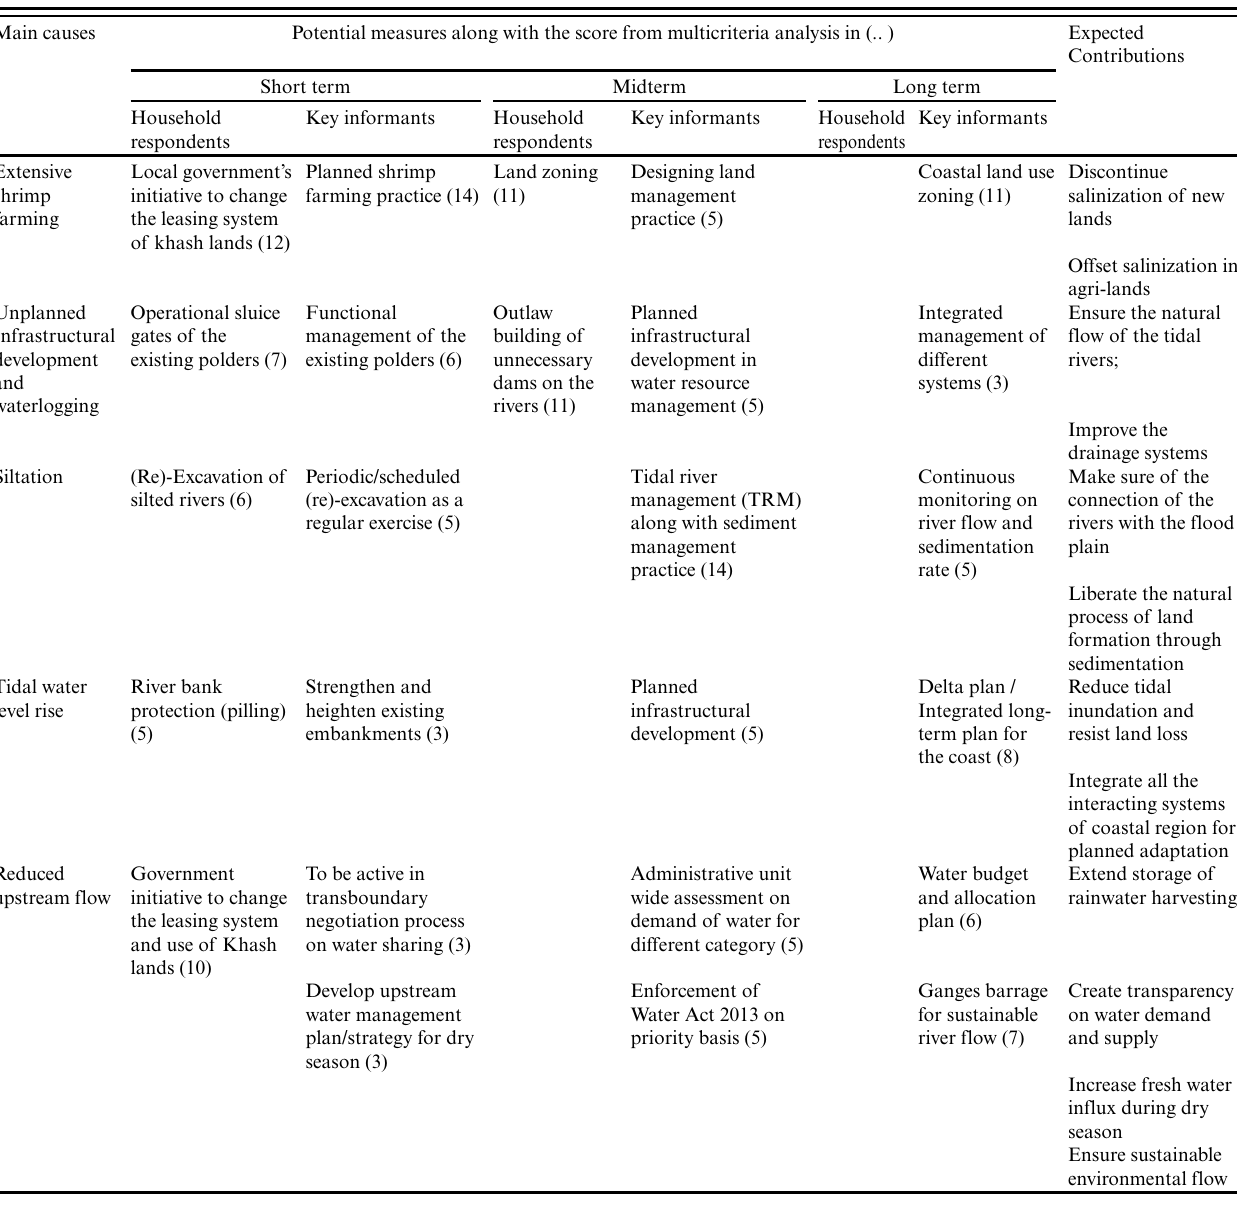
Table 5 . Potential set of measures and their contribution to address the observed causes of salinity increase. Main causes Potential measures along with the score from multicriteria analysis in (..